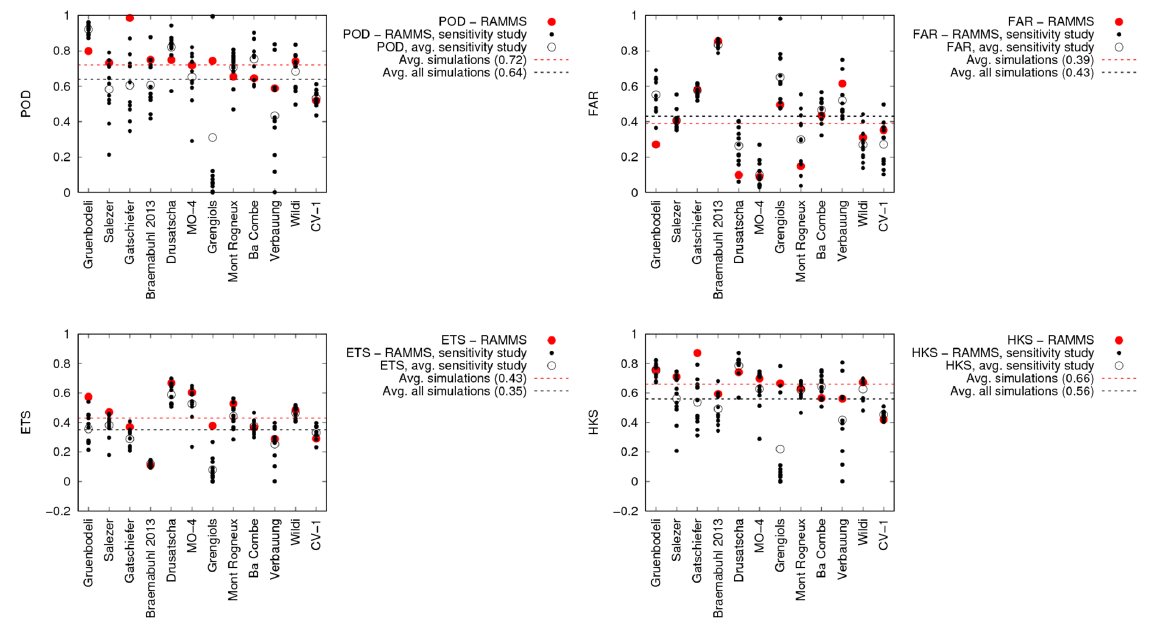
Figure 6. Sensitivity of the thermomechanical model RAMMS to permutations of avalanche mass (fracture height and density). For every avalanche path 12 different fracture heights, released densities, erosion heights and eroded densities are permuted, keeping the LWC and snow temperature constant. Markers and colors as in Fig. 5.